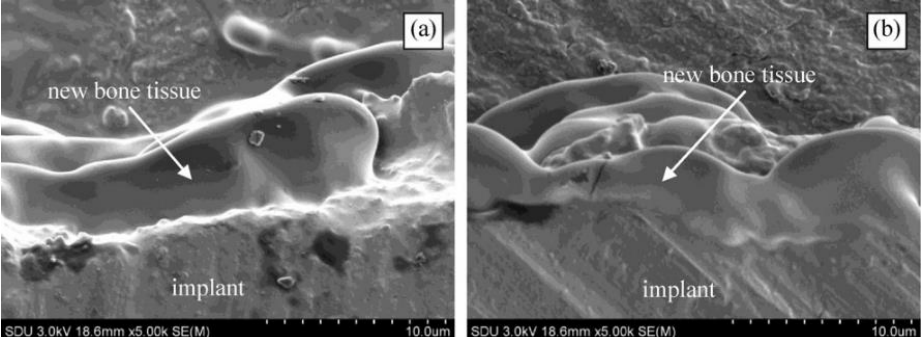
Figure 1. Morphologies of the implants after embedding for 1 month. ( a , b ) are the SEM morphologies of 200 and 600 °C films. (Reprinted with permission from [52]. Copyright 2013 Elsevier).